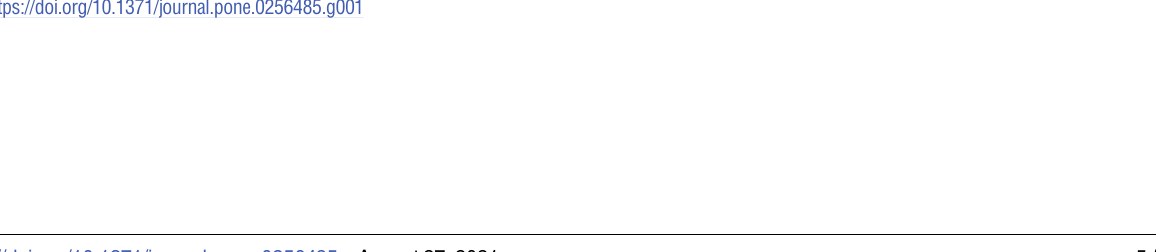
PLOS ONE | https://doi.org/10.1371/journal.pone.0256485 August 27,